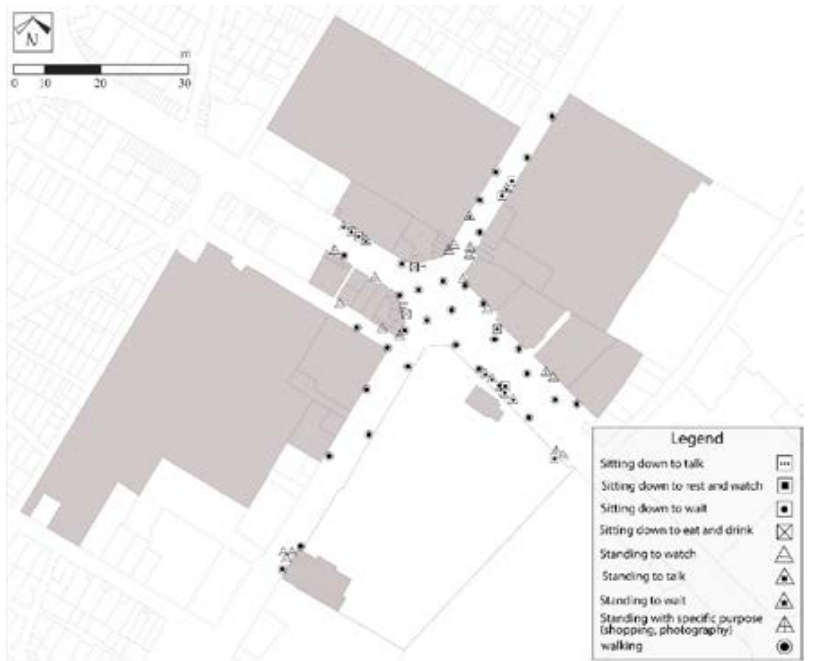
Fig. 7: Locations and types of activities (noon); source: authors